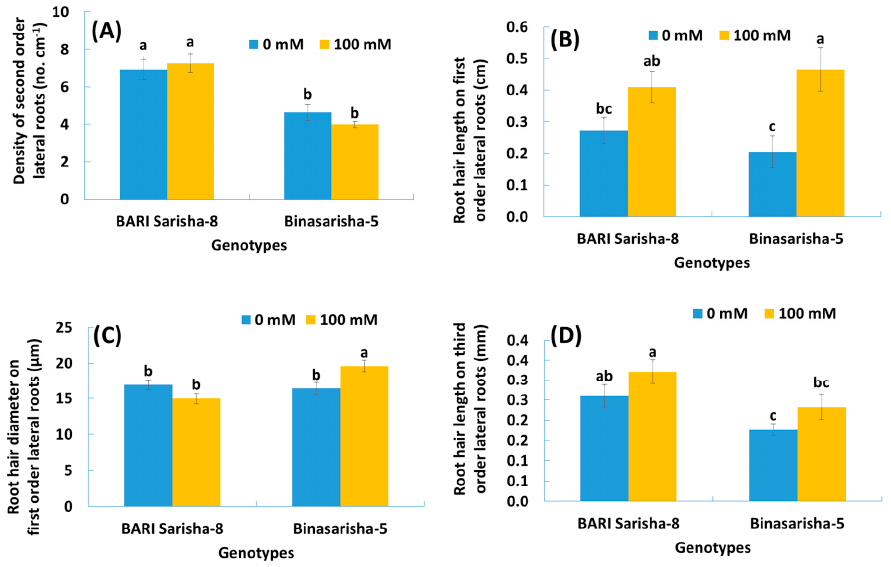
Figure 6. ( A ) Density of second-order lateral roots, ( B ) length of root hairs originating on first-order lateral roots, ( C ) diameter of root hairs originating on first-order lateral roots, and ( D ) length of root hairs originating on third-order lateral roots of two rapeseed varieties under 0 mM and 100 mM NaCl treatments. Vertical bars indicate standard error of mean of four replicates against each variable. Different letters indicate significant differences among the genotype × treatment interactions.